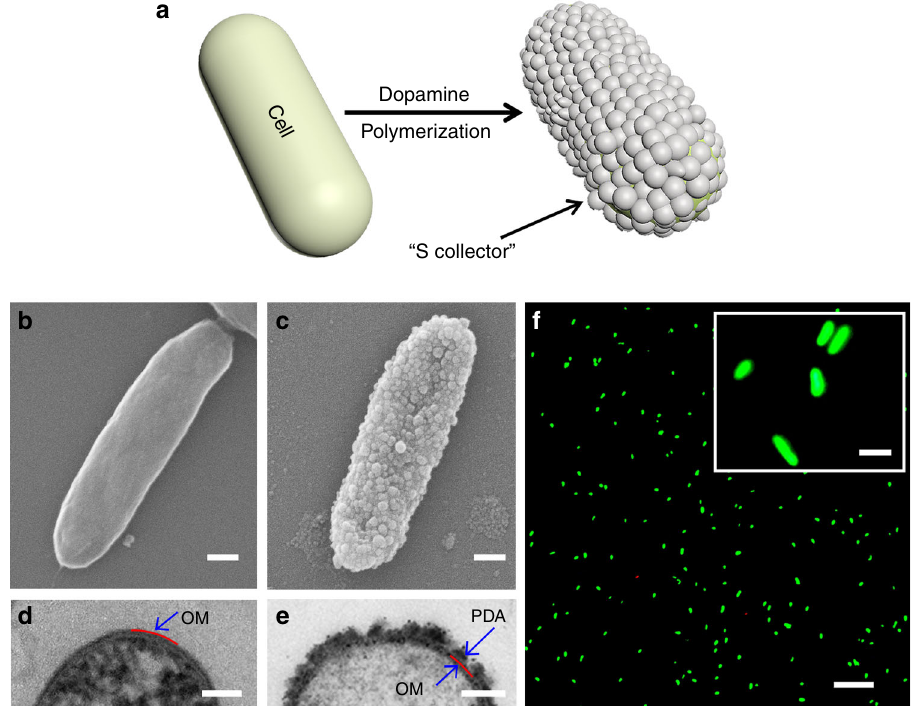
Fig. 2 Assembly of the S collector on an SW cell. a Schematic illustration of S collector assembly. SEM images of b a native SW cell and c an SW@S cell. TEM images of d a sliced native SW cell and e a sliced SW@S cell. PDA, polydopamine nanoparticle; OM: outer membrane of the SW cell. f Fluorescence microscopy image of SW@S cells stained with the LIVE/DEAD assay kit. Green fl uorescence indicates living cells; red fl uorescence indicates dead cells. Scale bars: b , c 200 nm; d , e 100 nm; f 20 μ m; inset of f 2 μ m. The inset of f shows an enlarged view of stained